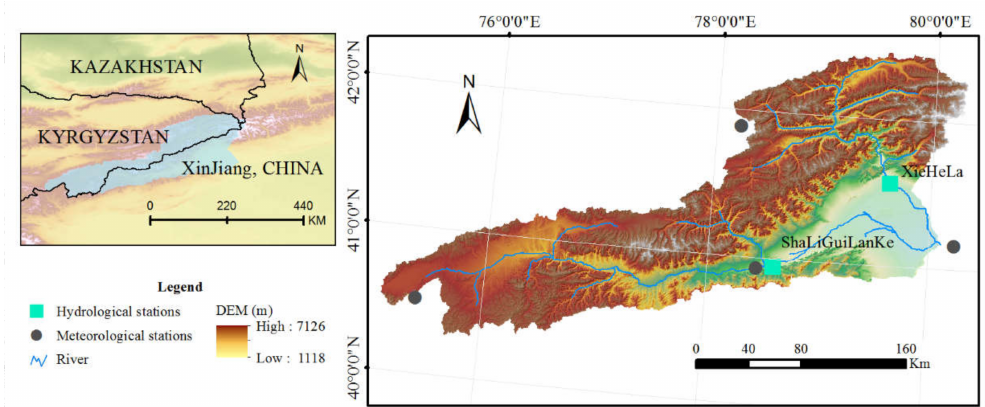
Figure 1. Geographical location and water systems of the Aksu River